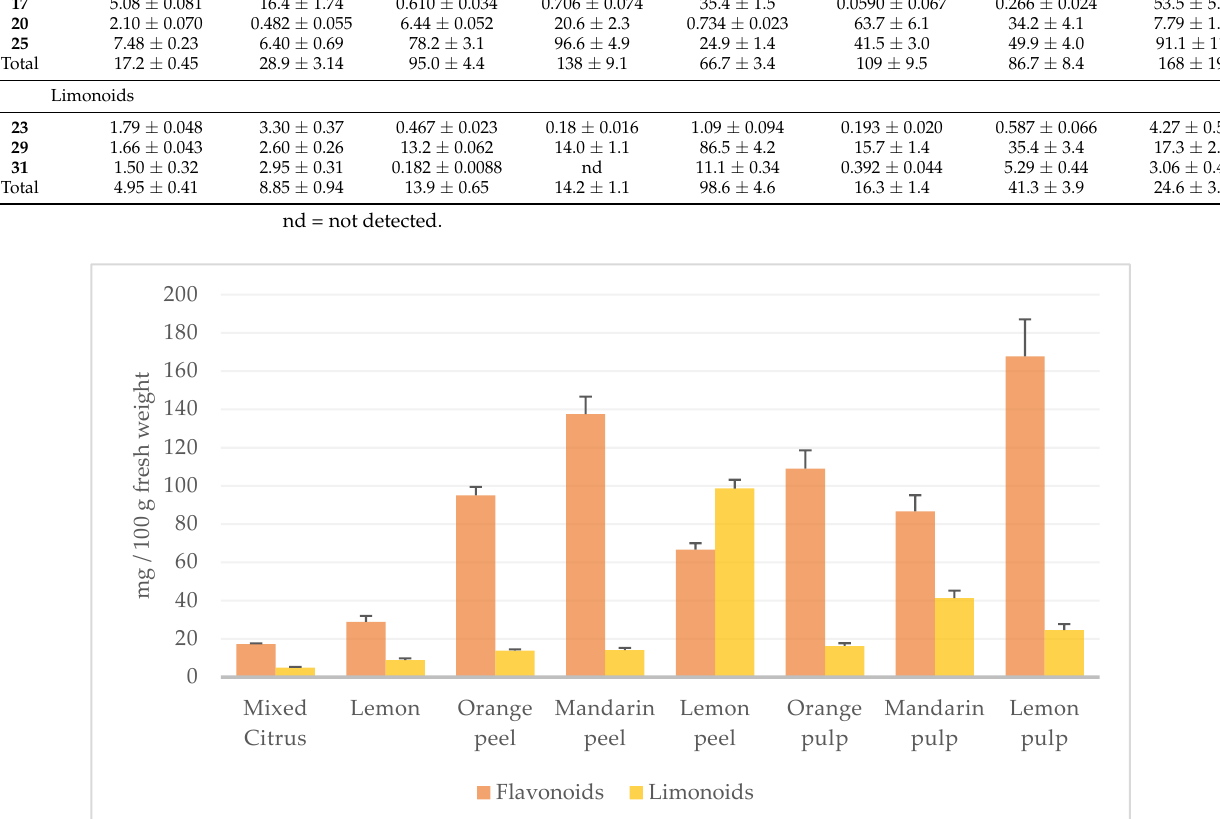
Figure 4. Distribution of flavonoids and limonoids in Coctura ® products (Mixed Citrus and Lemon) and fresh Citrus fruits.